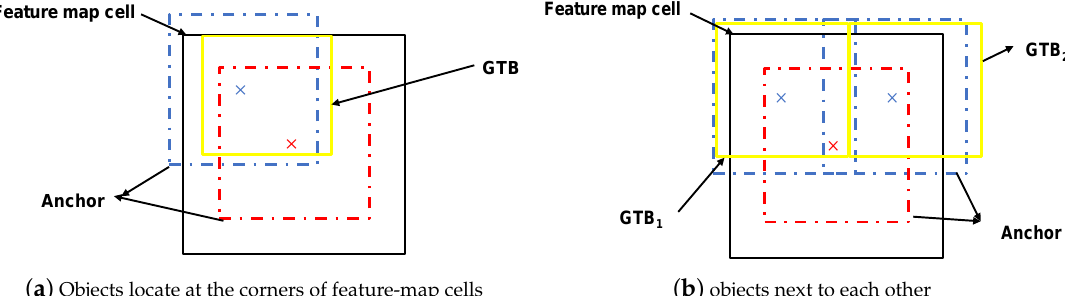
Figure 2. Explanation of the limitations in anchors provided by RefineDet. ( a ) Objects locate at the corners of feature-map cells, ( b ) objects next to each